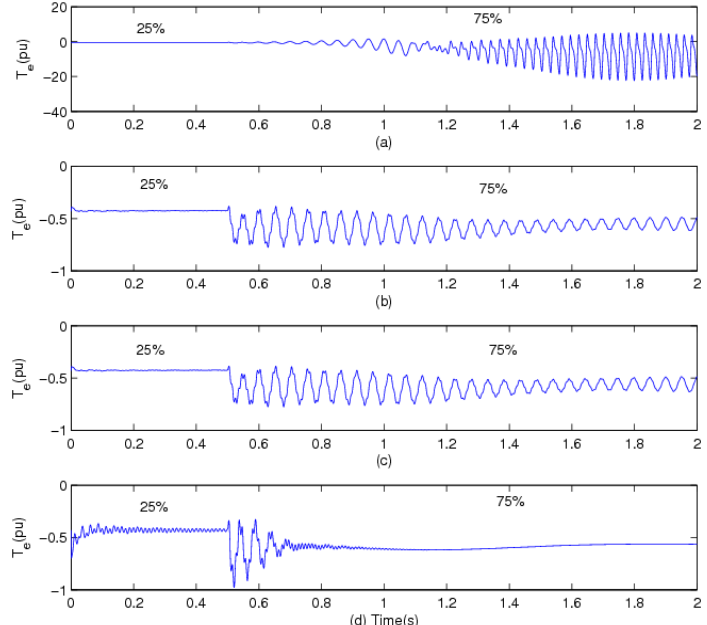
Figure 10. Dynamic responses of T ( b ) supplementary control loop in the d-axis of the GSC outer loop ( K ( c ) supplementary control loop in the d-axis of the GSC inner loop ( K ( d ) supplementary control loop in the q-axis of the GSC inner loop ( K damping controller input